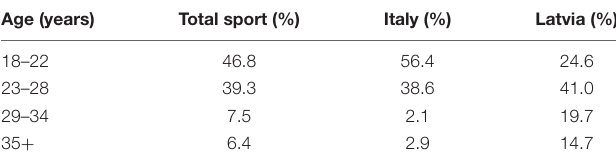
TABLE 4 | Age distribution for sport students (%).